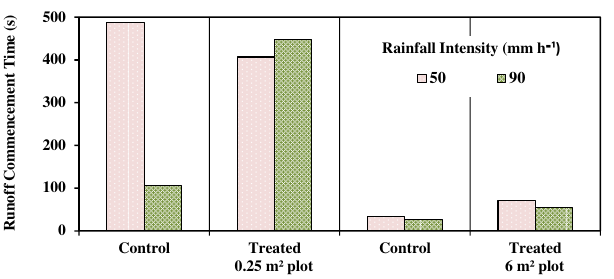
Figure 4. Average sediment concentration for the two study scales and the two rainfall intensities.